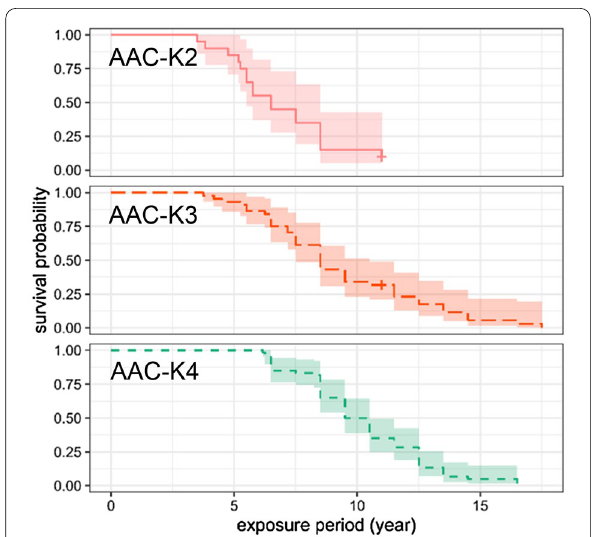
Fig. 1 Kaplan–Meier curves for stakes impregnated with AAC-1 at different performance classifications. Information on the stakes is shown in Table 1. AAC-1 alkylammonium chloride